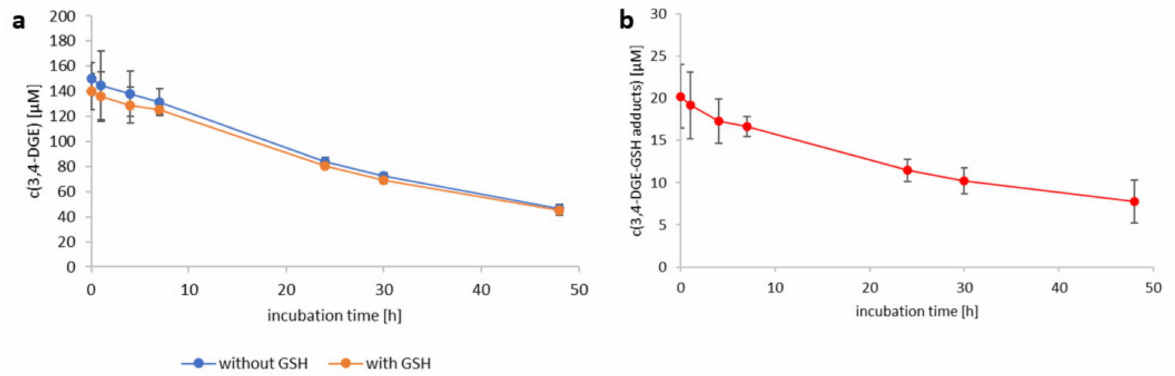
Figure 5. L -Glutathione (GSH) leads to an immediate formation of monoadducts with 3,4- dideoxyglucosone-3-ene (3,4-DGE). ( a ) Time-course curves are shown for the concentrations (in µ M, mean ± SD; 3,4-DGE start concentration as analyzed 150.0 µ M) of 3,4-DGE during 48 h of incu- bation at 37 ◦ C either in absence (blue curve) or presence (orange curve) of GSH (18.2 µ M). ( b ) The time-course curve for the concentration of the formed monoadducts is shown in red. The interconver- sion of 3,4-DGE to 3-deoxyglucosone (3-DG) and 3-deoxygalactosone (3-DGal) was not affected. All experiments were performed in triplicates; the areas of the two 3,4-DGE–GSH monoadducts were summed up. The differences between the samples with and without GSH are not